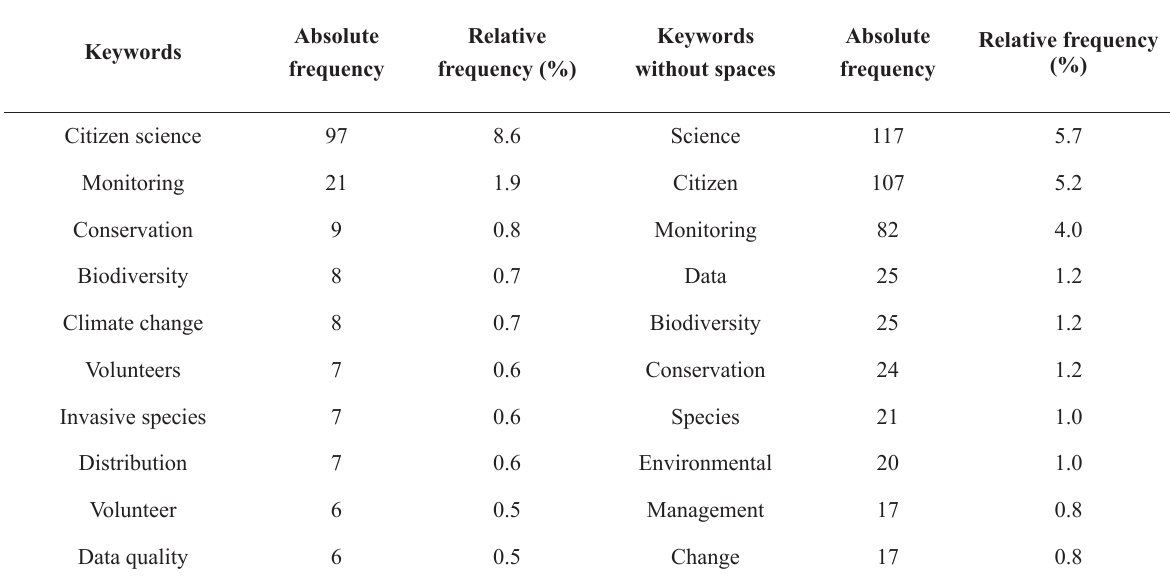
Ten keywords (with or without spaces) with the highest absolute and relative frequency (%) from the 303 analyzed peer- reviewed articles.